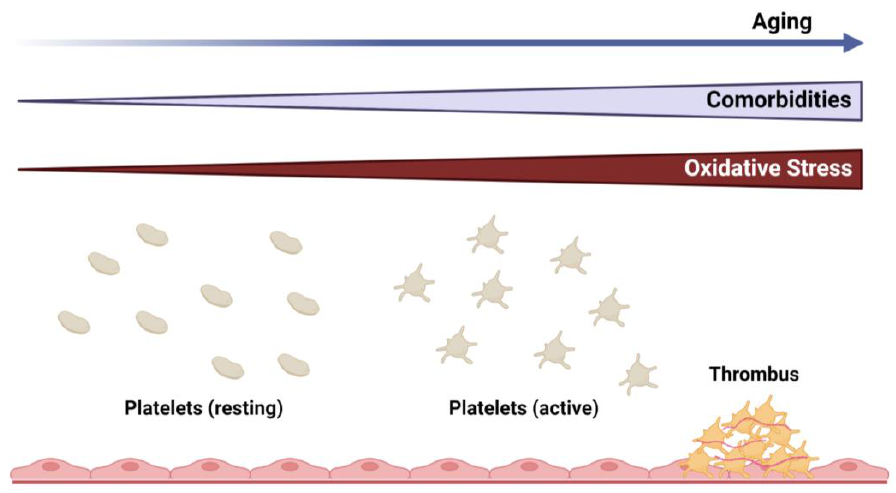
Figure 1. Overview of the relationship between aging and vascular disease, highlighting the pathogenic role of platelets. Cardiovascular comorbidities and oxidative stress are increased with advancing age, which can promote platelet activation and thrombus formation.